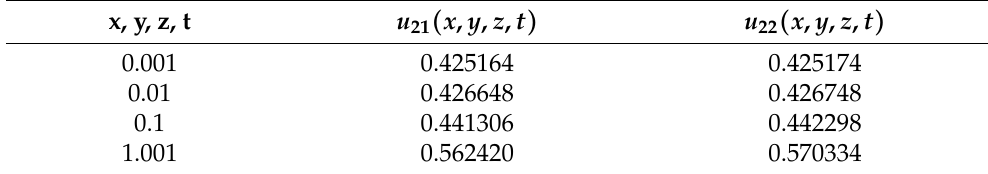
Table 2. Numerical solutions for two wave solutions of (1).